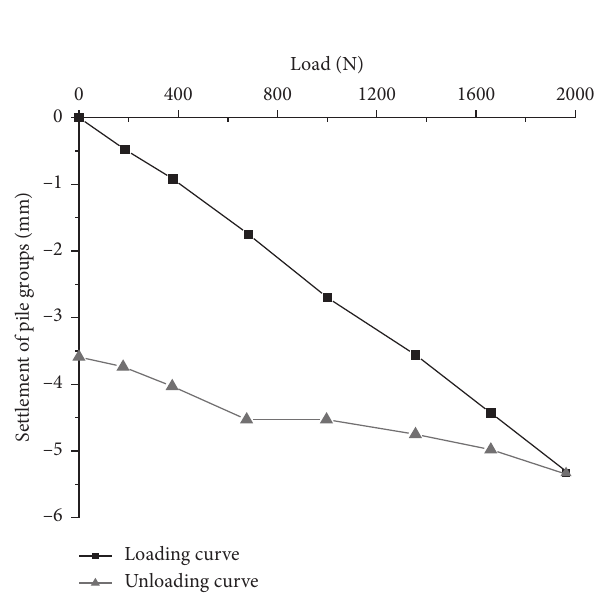
Figure 6: Variation curve of settlement: loading and unloading of pile